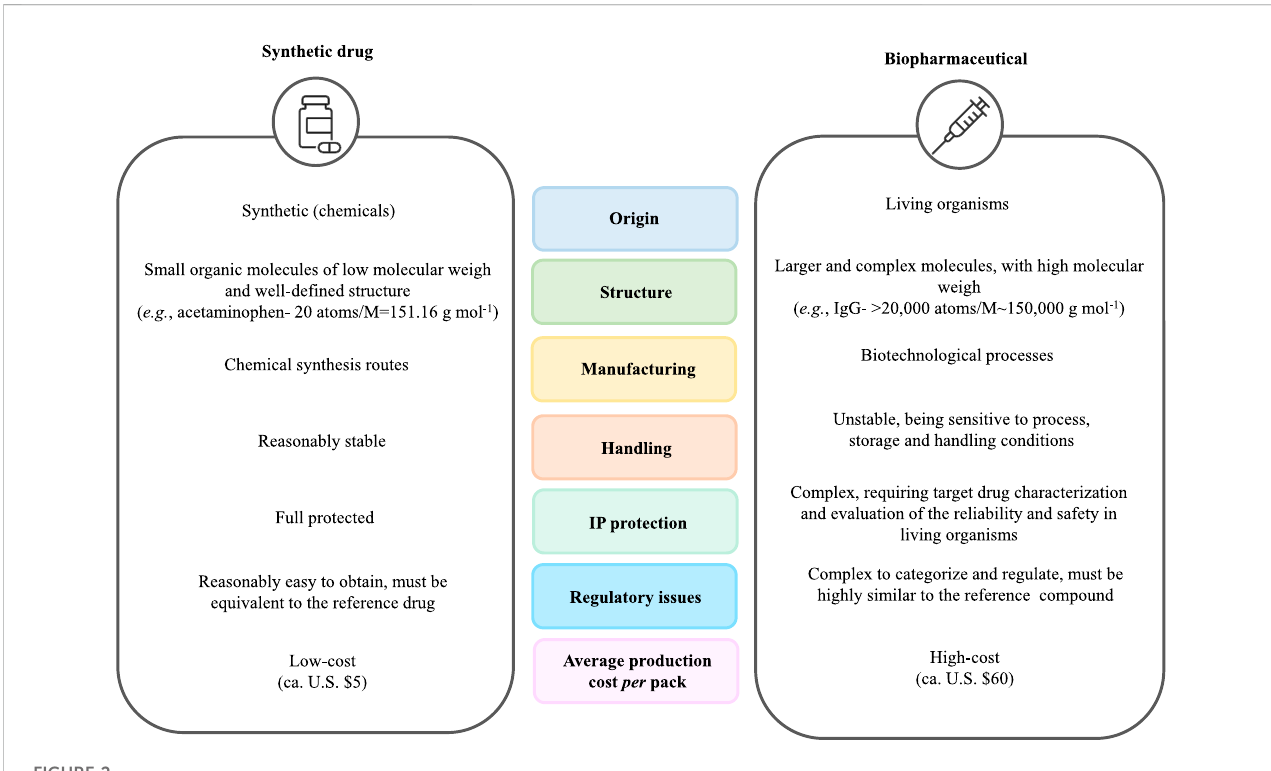
FIGURE 2 Comparison between conventional synthetic drugs and